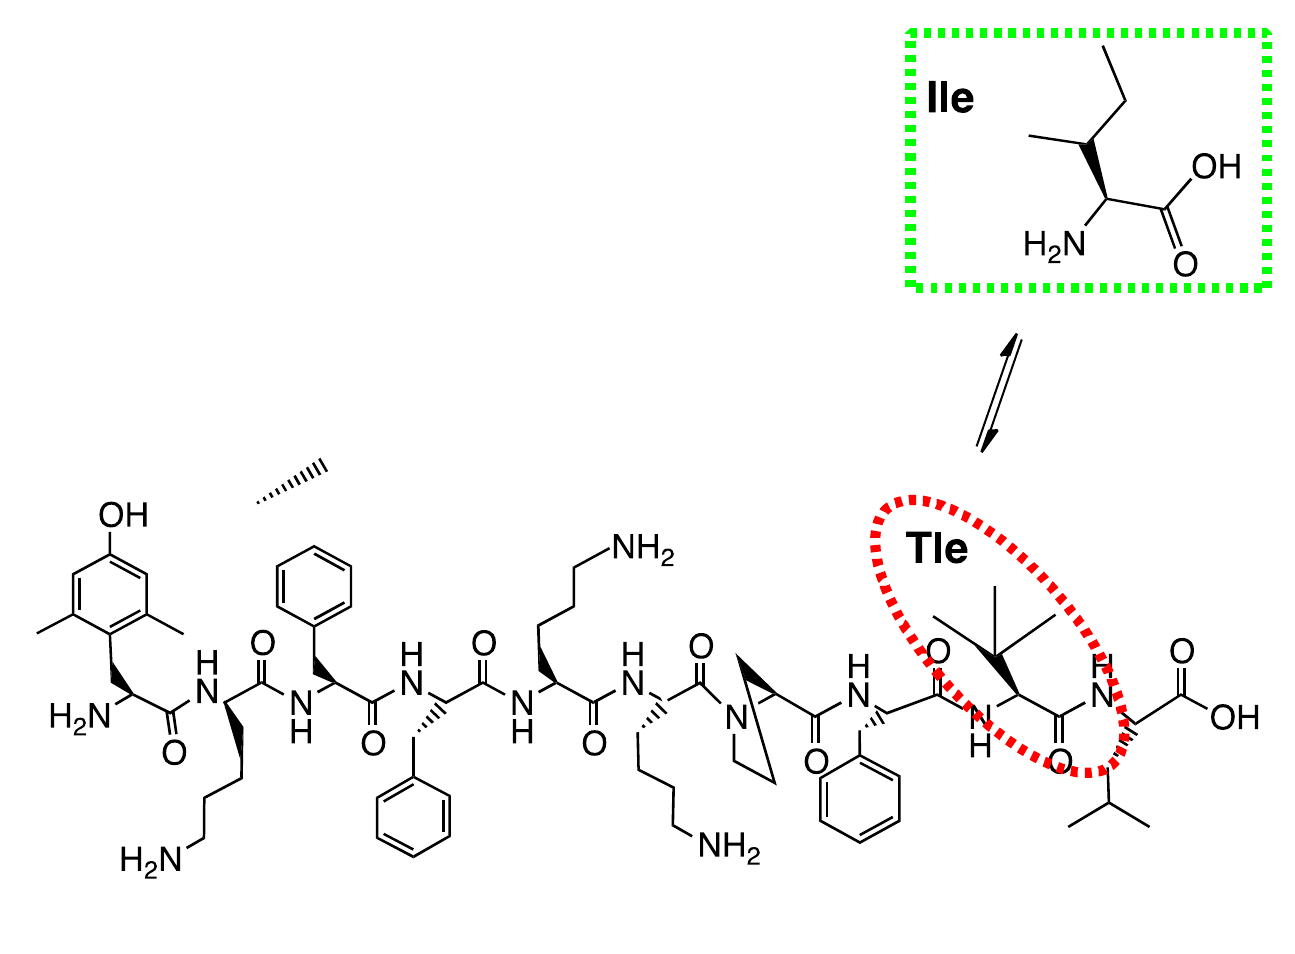
Figure 1. Chemical structure of the PK20 opioid–neurotensin hybrid peptide with the indication of a performed modification resulting in the production of [Ile 9 ]PK20.